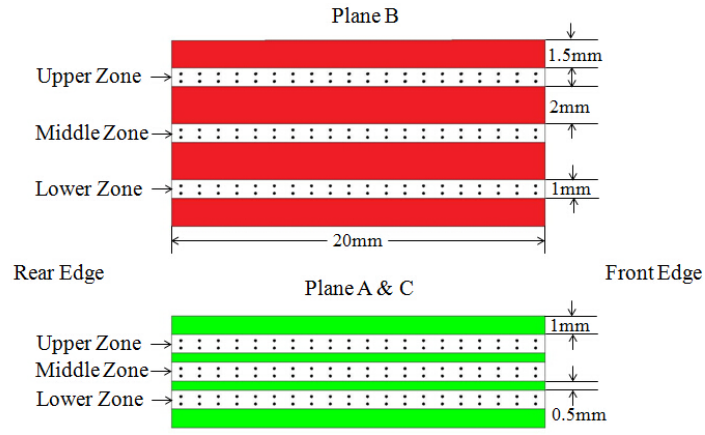
Figure 3. Schematic illustrations of the positions of hardness measurement on planes.